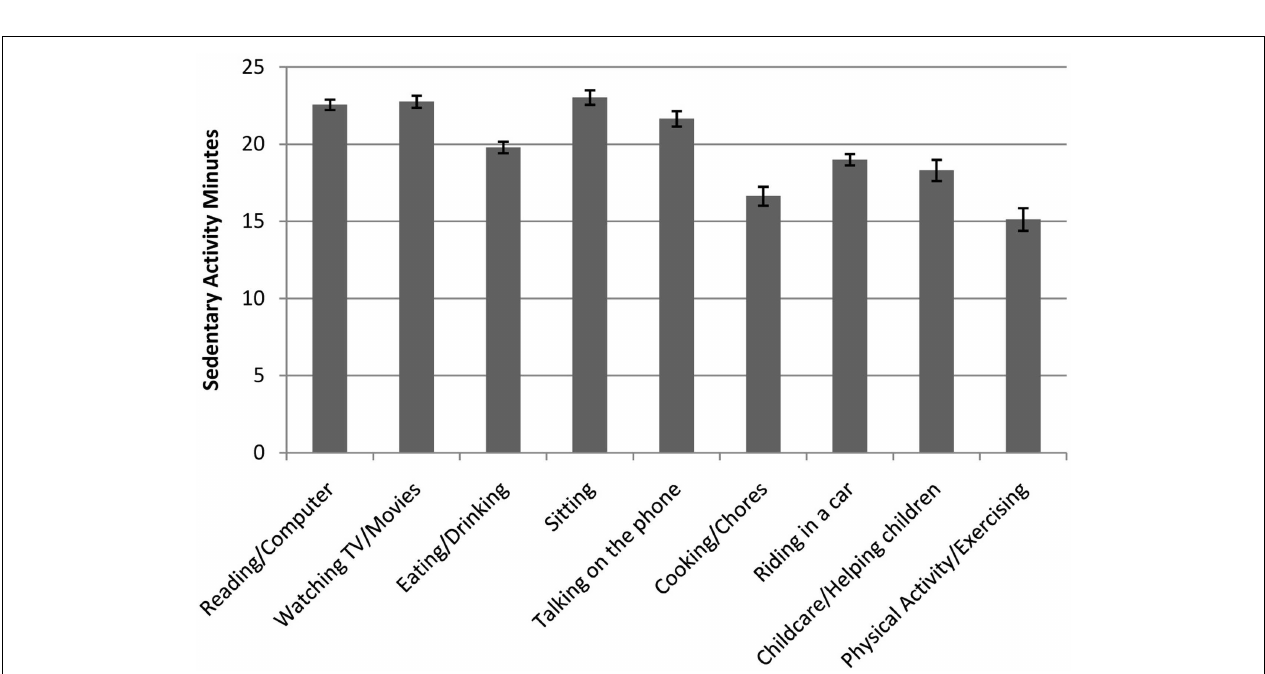
FIGURE 4 | Mean moderate-to-vigorous physical activity (MVPA) minutes by activity categories self-reported through ecological momentary assessment (EMA). MVPA was recorded by accelerometer in the ± 15min window of each answered EMA survey prompt.Values represent the